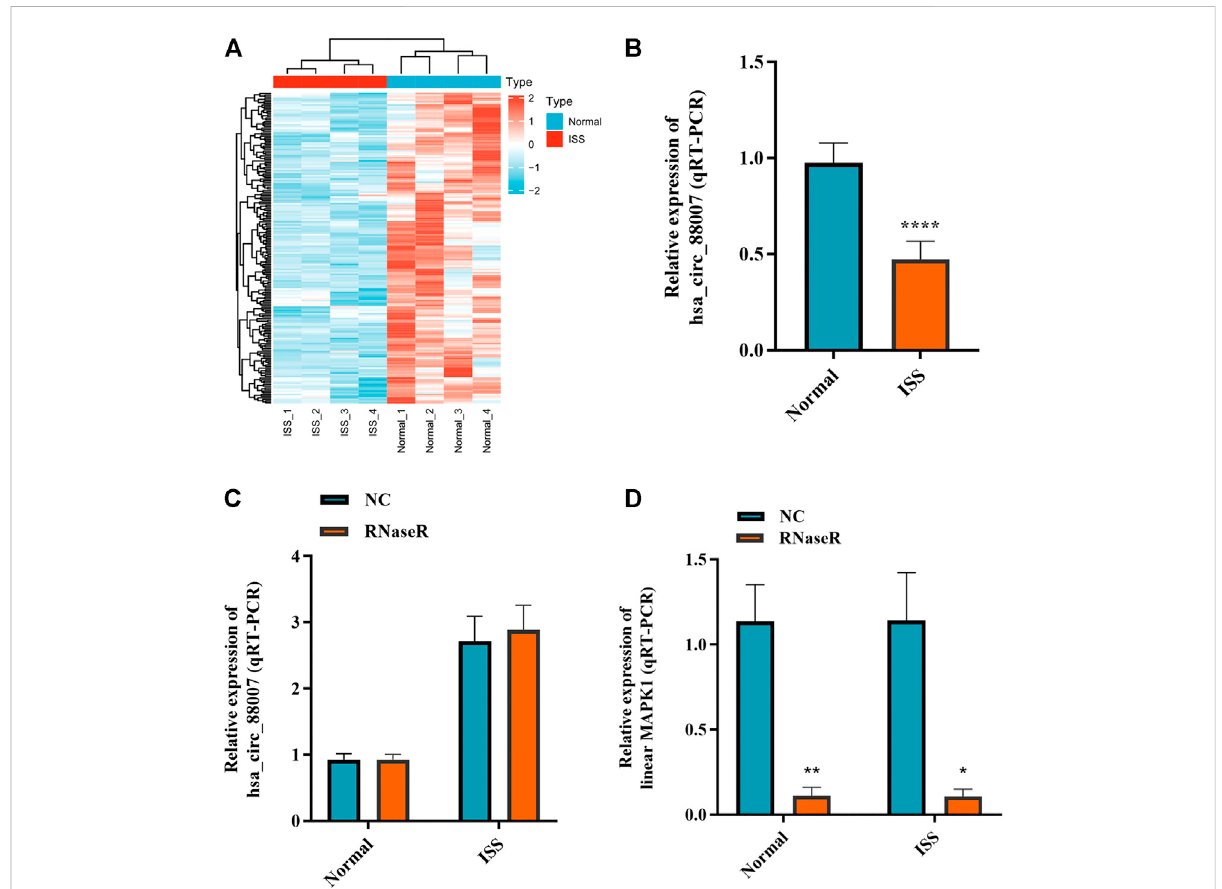
FIGURE 1 The expression of hsa_circ_0008870 in peripheral blood of ISS is downregulated. (A) Heatmap changes of downregulated circRNAs between the two groups. (B) Downregulated hsa_circ_0008870 in ISS patients were validated by RT-qPCR. (C) The expression of hsa_circ_0008870 was detected between the RNase R group and the normal control group. (D) The expression of liner MAPK1 was detected between the RNase R group and the normal control group. p > 0.05; *, p < 0.05; **, p < 0.01; ***, p < 0.001; ****, p <